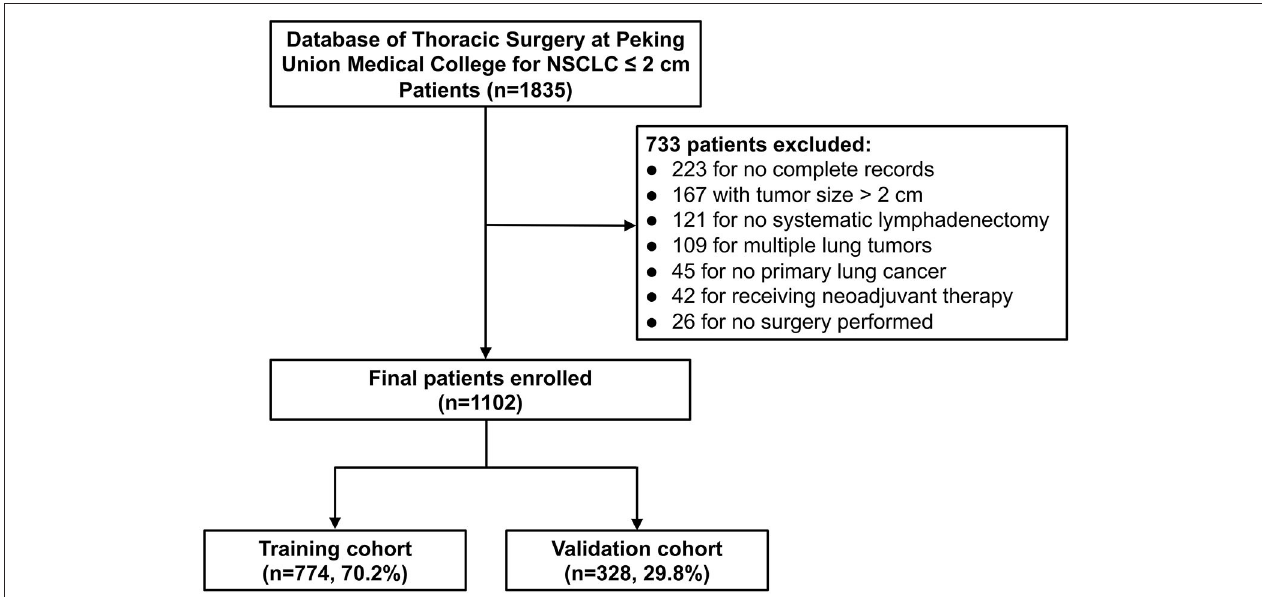
FIGURE 1 | Flowchart of the patients for the training and validation